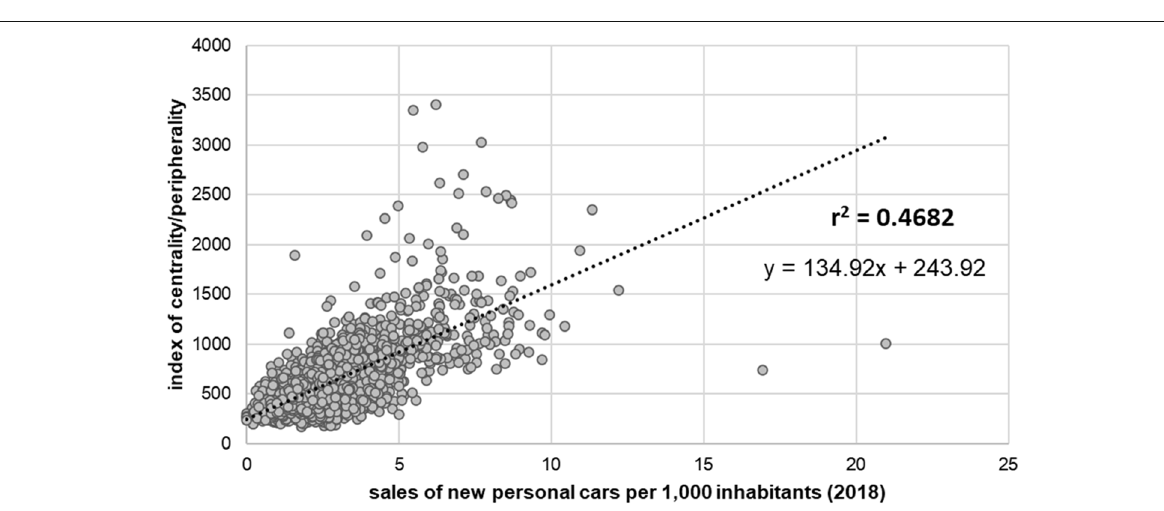
Fig. 4 Relationship between the centrality/peripherality index and the sales of new cars. Source: own elaboration based on the Ministry of Finance and Central Vehicle Agency data